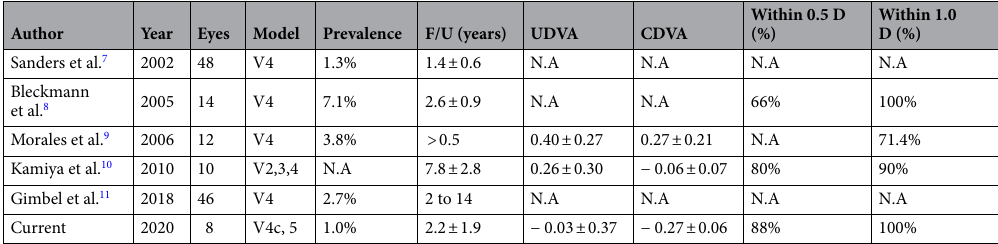
Table 2. Previous studies on the visual and refractive outcomes of implantable collamer lens (ICL) extraction. F/U follow up, UDVA uncorrected distance visual acuity, CDVA corrected distance visual acuity, D diopter, N.A. not